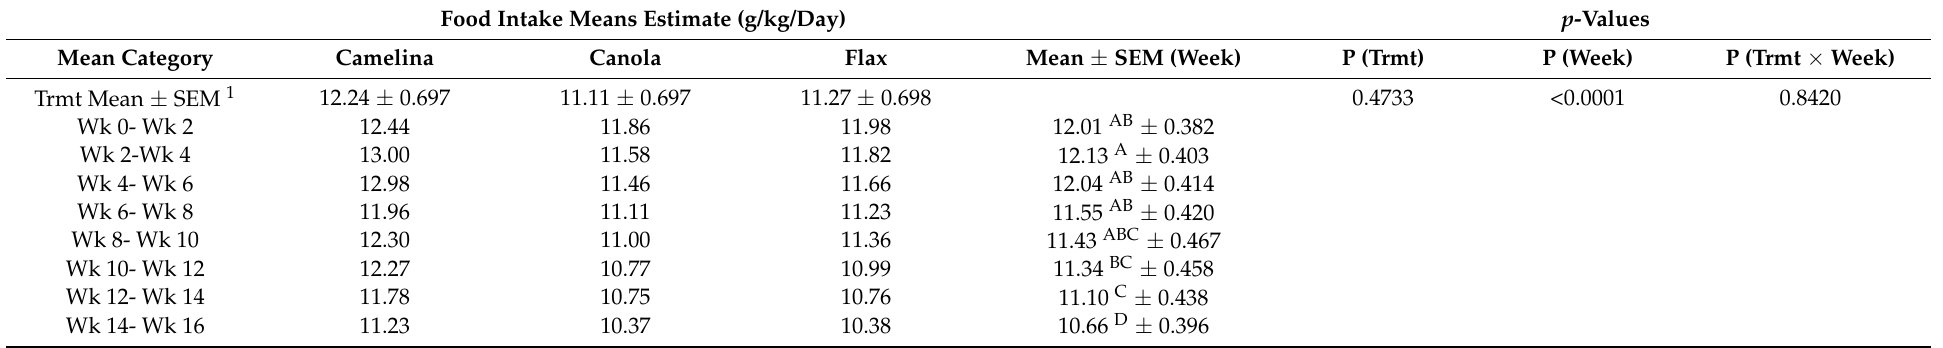
Table 3. Daily food intake for healthy, adult dogs fed one of three dietary oil supplements (camelina, flax, or canola oil) over a 16-week period. Values shown are lsmeans estimates for treatment (oil), week, and treatment by week